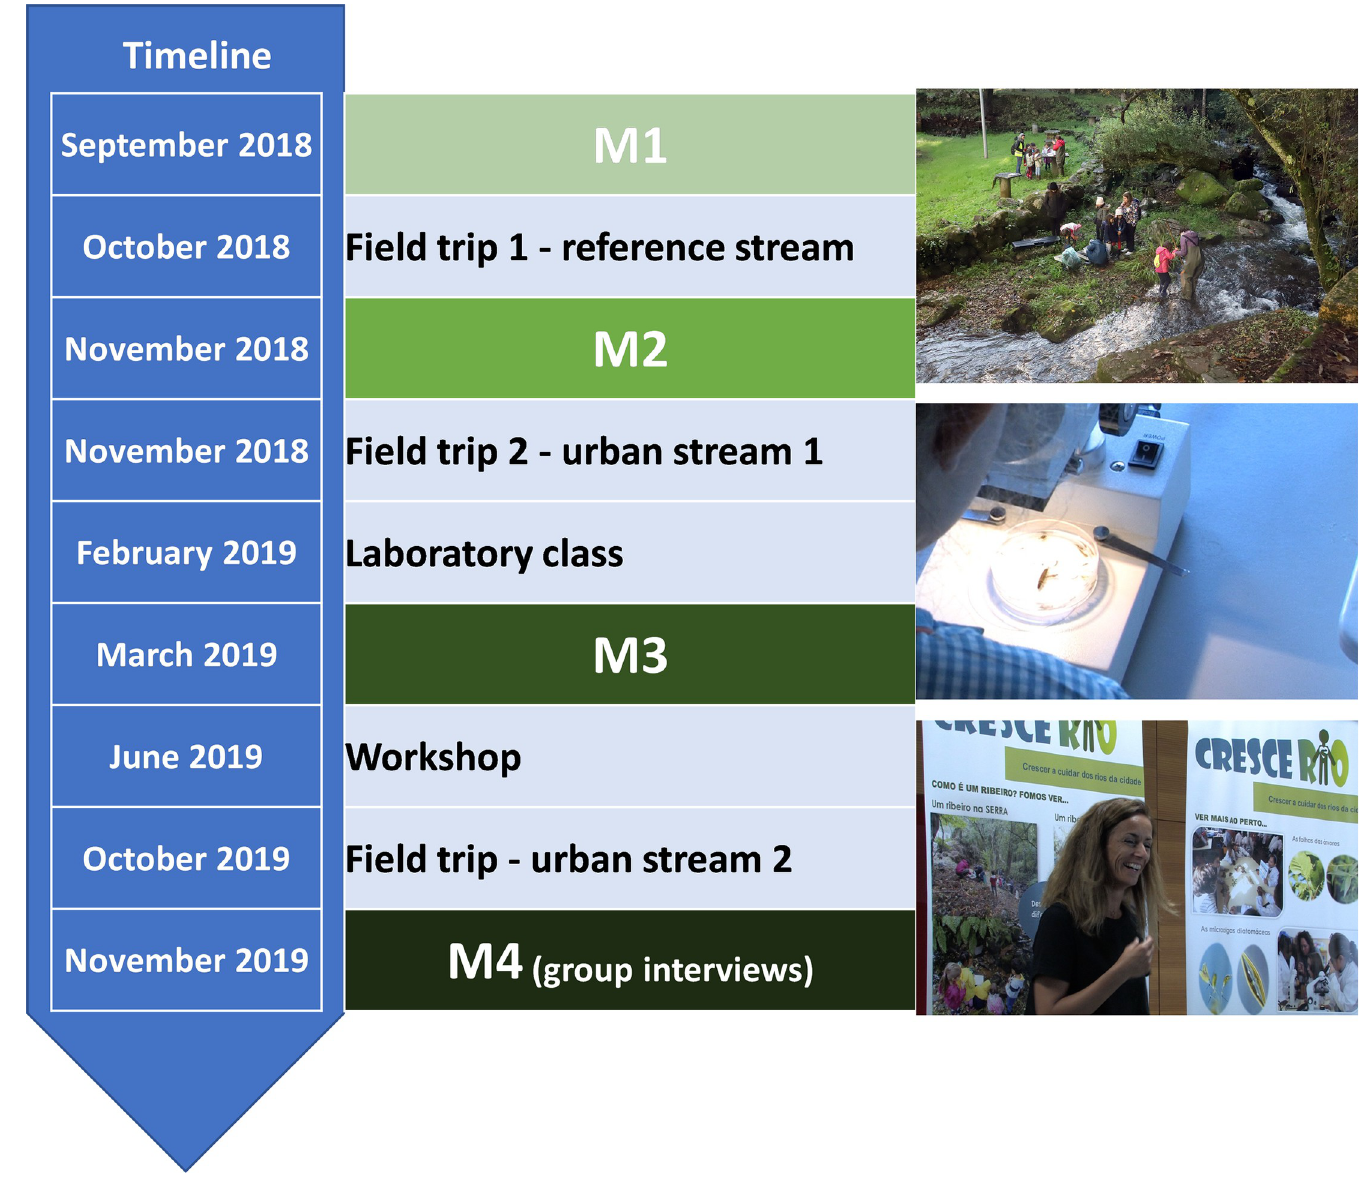
Fig 1. Timeline of CresceRio actions (field trips and laboratory class) and surveys to students (inquiries– M1-M3 and